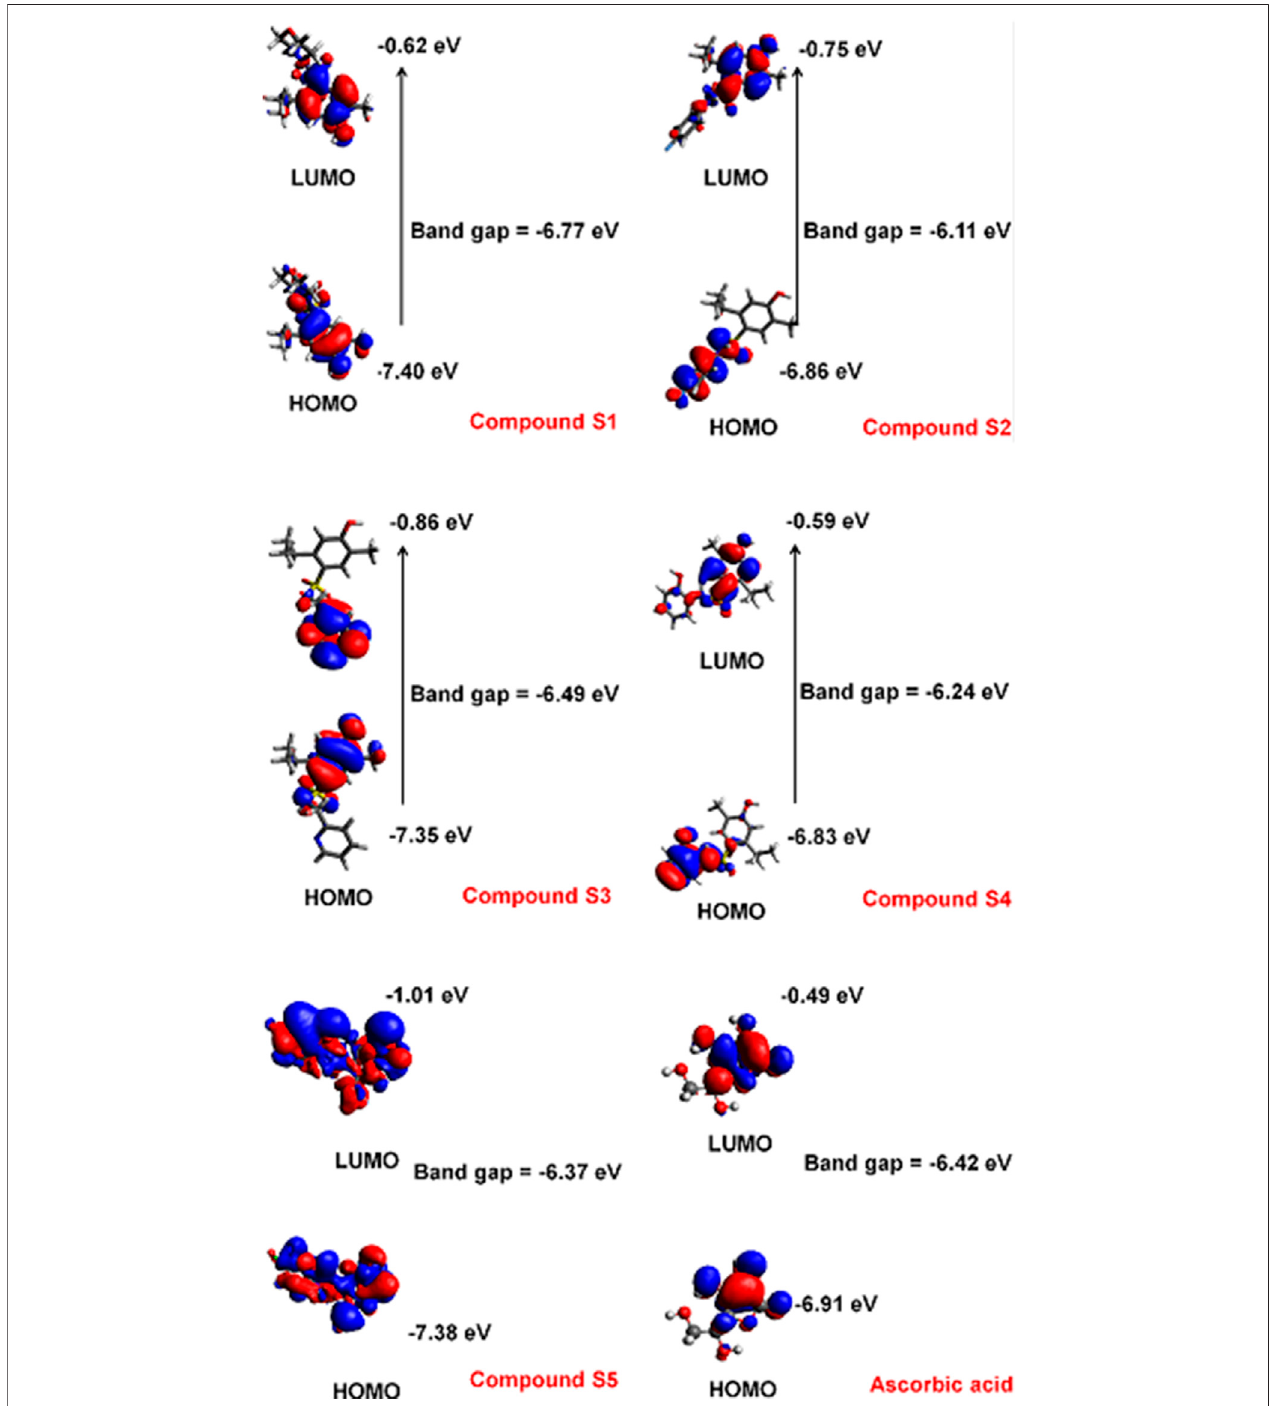
FIGURE 2 | HOMO and LUMO potentials of the carvacrol derivatives estimated by the B3LYP method and 6 – 31G(d,p) basis set.